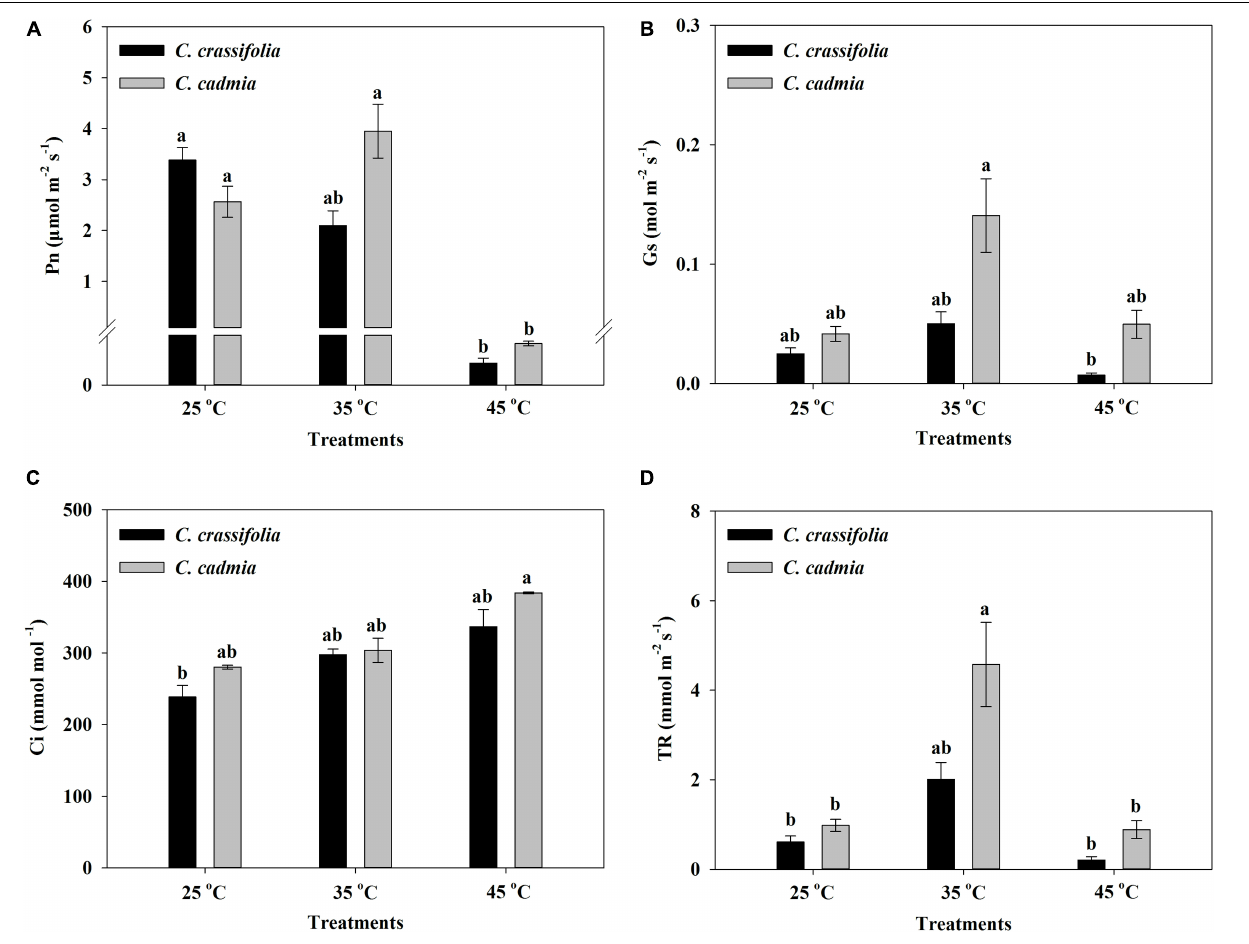
FIGURE 3 | Photosynthetic parameters of C. crassifolia and C. cadmia grown under three different temperatures including normal temperature (25 ◦ C), moderate temperature (35 ◦ C), and high temperature (45 ◦ C). (A) Net photosynthetic rate (P n ). (B) Stomatal conductance (Gs). (C) Intercellular CO 2 concentration (C i ). (D) Transpiration rate (TR). Error bars indicate SE ( n = 5 plants). Different letters indicate significant differences based on two-way ANOVA followed by Tukey multiple comparisons ( P ≤